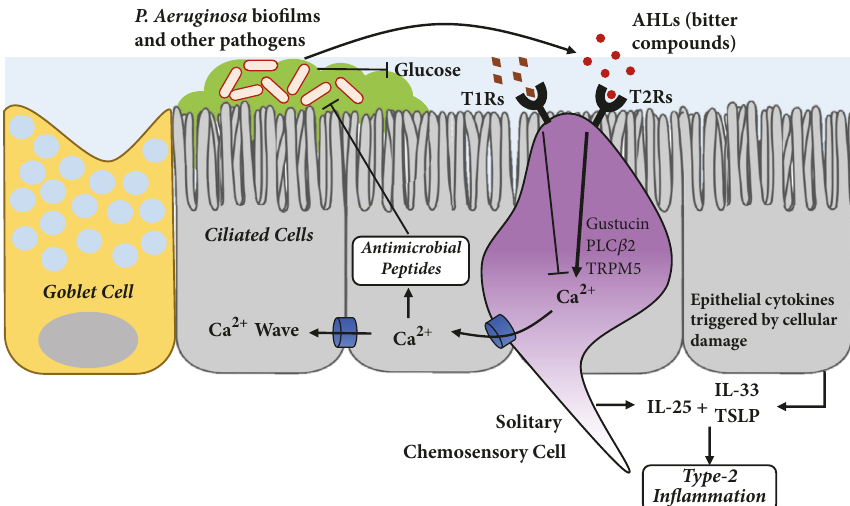
Figure 2: Solitary chemosensory cells (SCCs) express counteracting sweet receptors (T1Rs) and bitter receptors (T2Rs) that can cause a calcium wave leading to release of antimicrobial peptides. Solitary chemosensory cells have separately also been found to release innate cytokine, IL-25, and epithelial cells produce IL-33 and TSLP in the setting of cellular